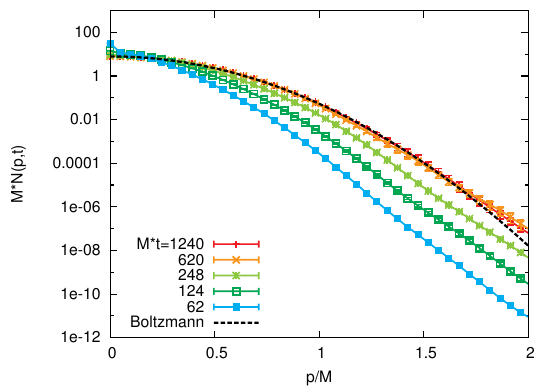
Figure 2 . Time evolution of the momentum distribution of a heavy quark. The bars denote statistical errors. The dashed line corresponds to the Boltzmann distribution with T = 0 : 1 M